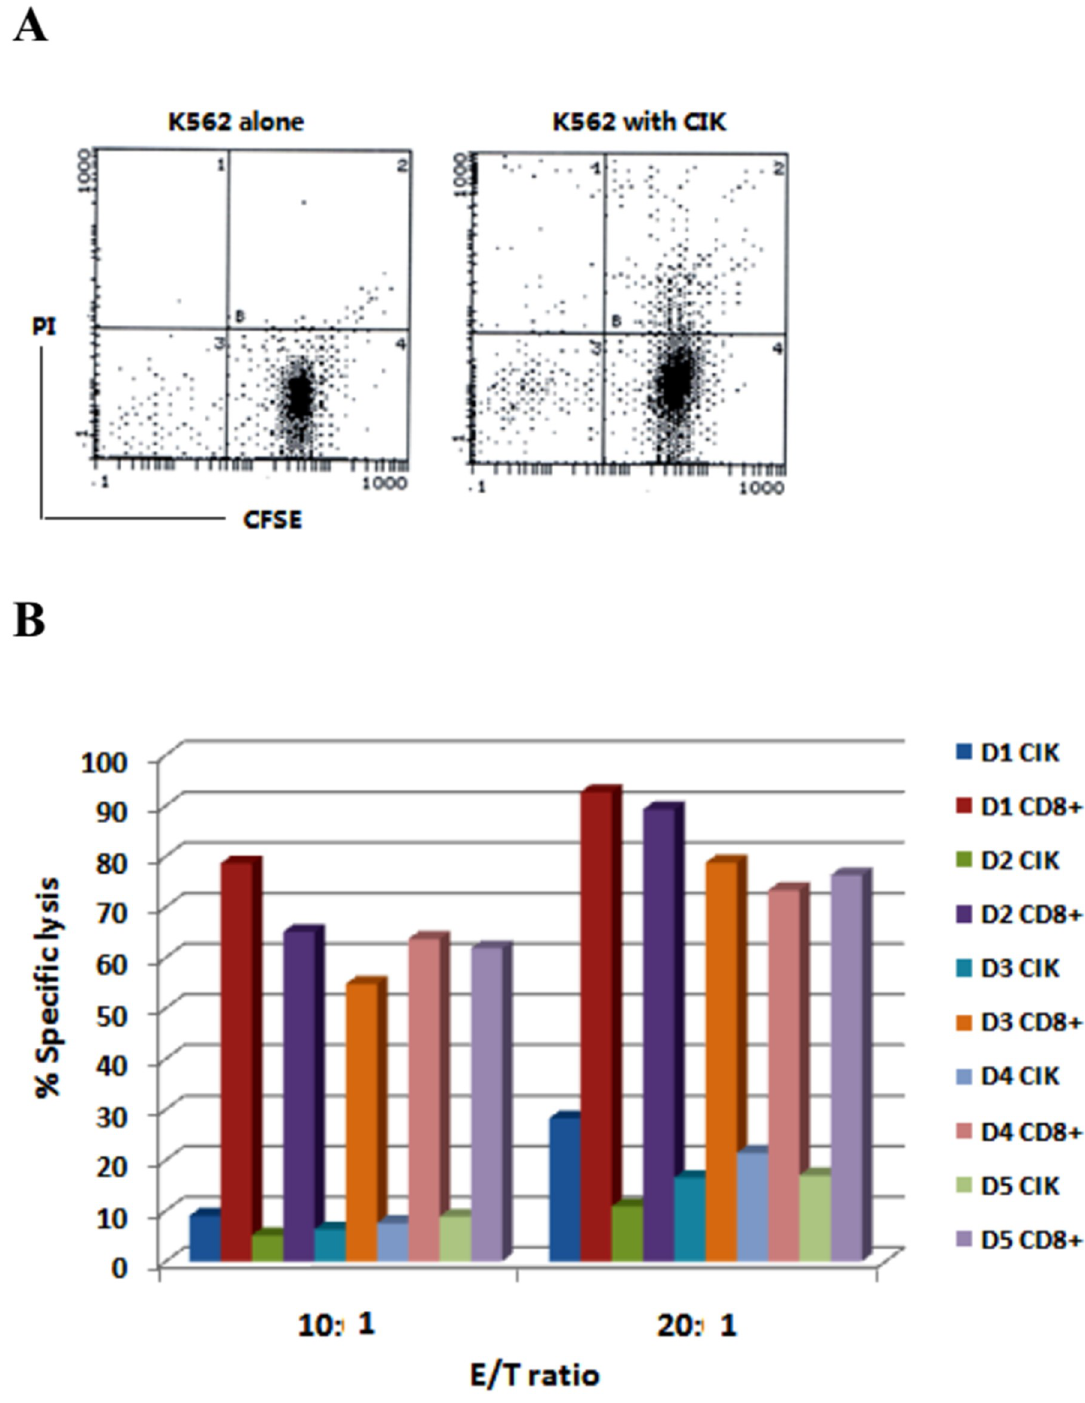
Fig 6. The cell killing activity of CIK cells and CD8+ CIK cells against K562 target as analyzed by flow cytometry. A. K562 cells were culturedalone or co-cultured with CIK cells (1:10) for 4h. Cell death was analyzedwith PI and CFSE staining coupledwith flow cytometry. B. K562 cells were co-cultured with CIK or CD8+ CIK cells from five donors (D1-D5) at ration of 1:10 or 1:20 for 4h. Cell death was analyzedwith PI and CFSE staining coupledwith flow cytometry.